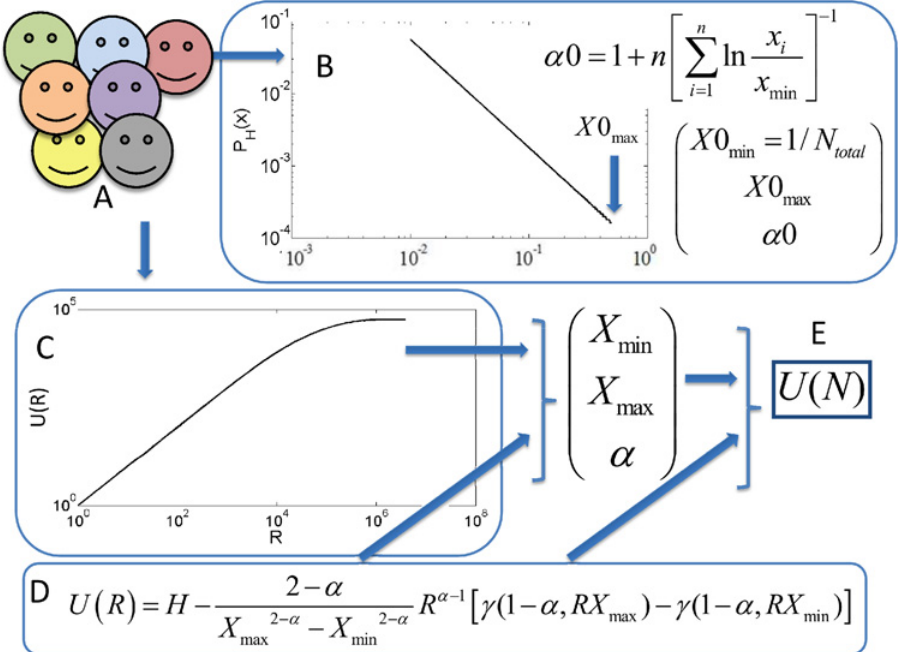
Fig 2. Schematic figure. (A) We observe a population with different haplotypes. From the population we extract two measures — the haplotype frequency distribution (B) and the number of unique haplotypes as a function of the sample size (C). We assume that the frequency distribution (B) is a scale free distribution with upper and lower cutoff values X min (cid:2) x (cid:2) X max . For the sake of simplicity, we assume a zero probability to observe haplotypes with frequencies beyond these values. We provide an initial guess for the lower cutoff to be limited by the total population size, and the upper cutoff, we limit by an upper estimate from the total population size (Eq B6). We use an initial guess of X min at its boundary, the Clauset estimate for the slope, and the observed highest frequency X 0 max . We then fit the observed unique haplotype curve (C) with an X analytical formula for the expected shape (D) with a cost function of R 0 log ð observed ð R 0 ÞÞ for different values of sample sizes R'. Finally, we extract the optimal parameters (E) and produce an estimate of the number of unique haplotypes for any population size N, where N is the target population